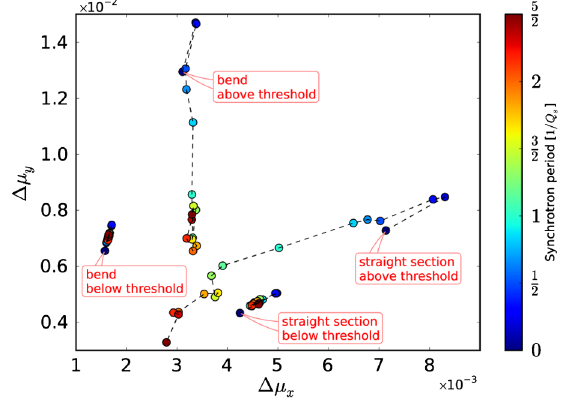
FIG. 21. Incoherent tune shift evolution at 450 GeV and a transverse normalized emittance of 2 : 5 (cid:3) m for different cases.